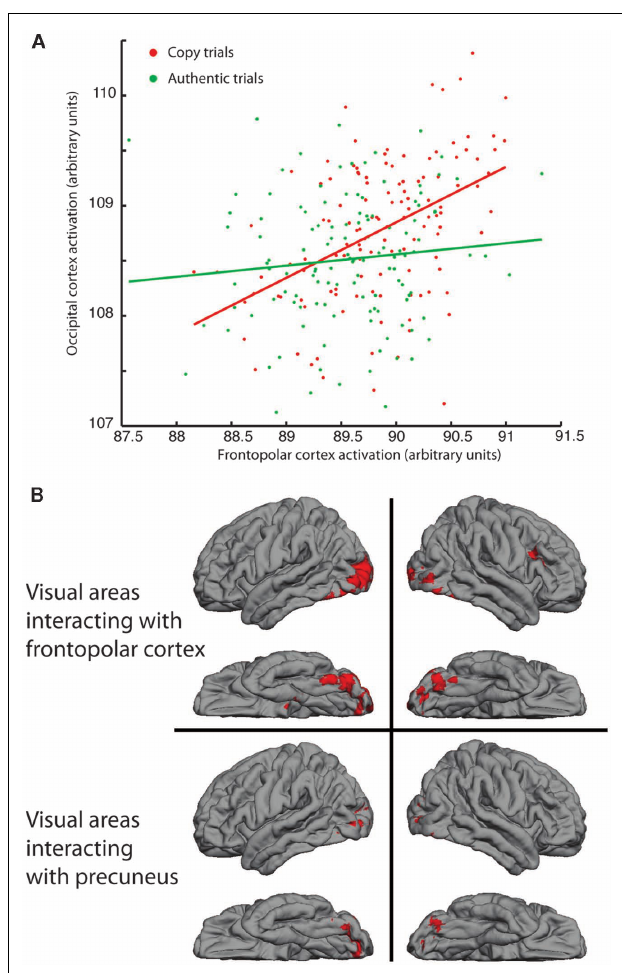
FIGURE 3 | Responses of right frontopolar cortex (FPC) and precuneus and their interaction with visual processing of images. (A) Functional activations, under COPY and AUTHENTIC assignments, of occipital regions of a single participant plotted against activations in right FPC. Stronger correlation between signals under COPY assignment ( r = 0.46; p < 0.0001) compared with AUTHENTIC ( r = 0.11; p > 0.2). (B) Psycho-physiological interaction (PPI) on group data from all right-handed participants, showing regions of occipital cortex whose correlation with right FPC (upper) and precuneus (lower) increases significantly in the COPY condition compared with the